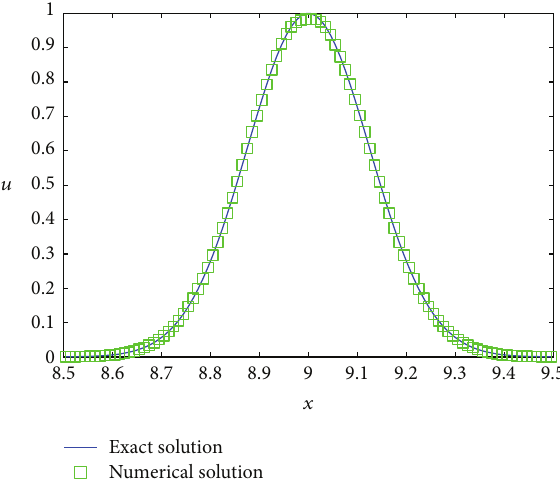
Figure 1: SHA method applied to linear advection equation with a continuous initial value; numerical (symbols) and exact (line) solutions are compared at 𝑡 = 9 units.